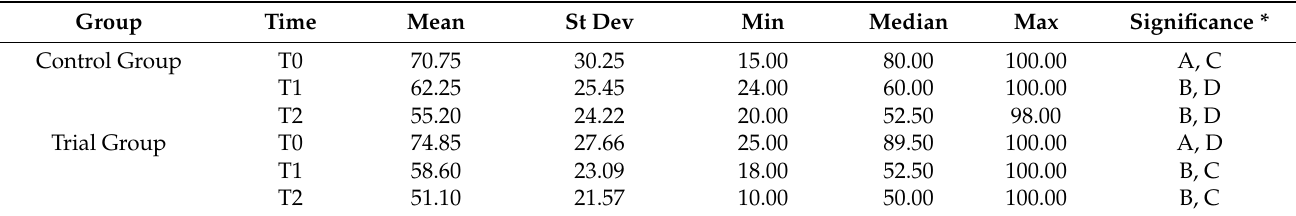
Table 6. Descriptive statistics of PI measurements.